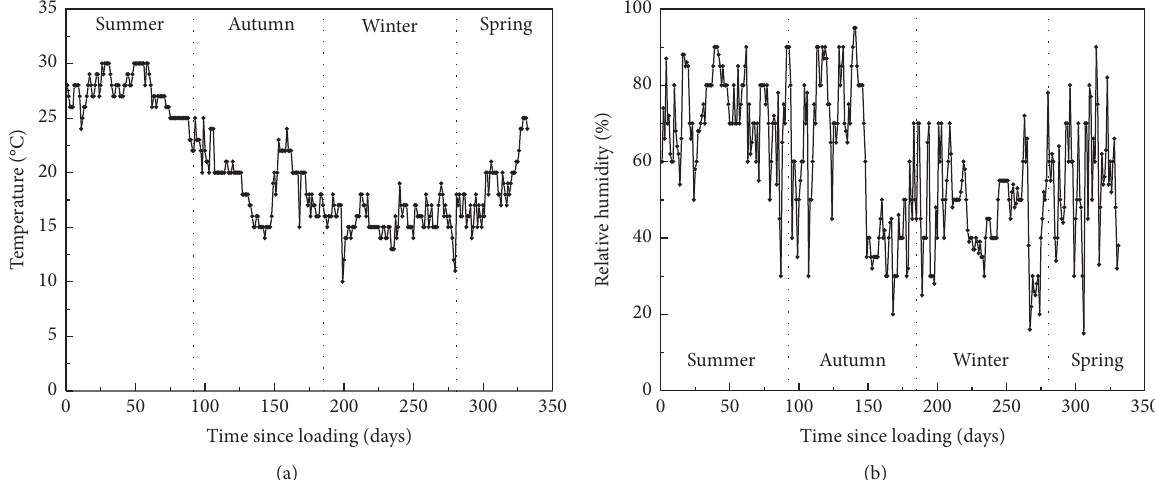
Figure 3: Temperature and humidity variations. (a) Temperature. (b) Relative humidity.